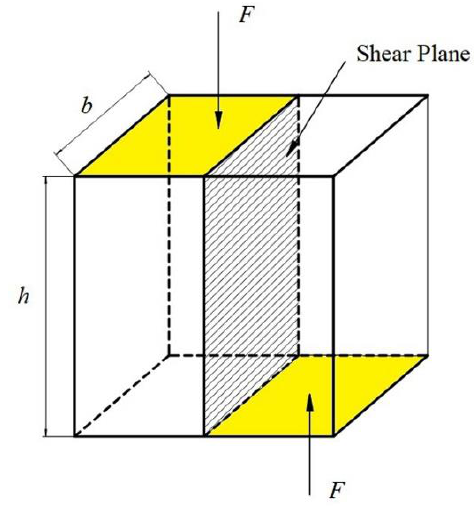
Figure 2. Schematic diagram of single-sided shear test.